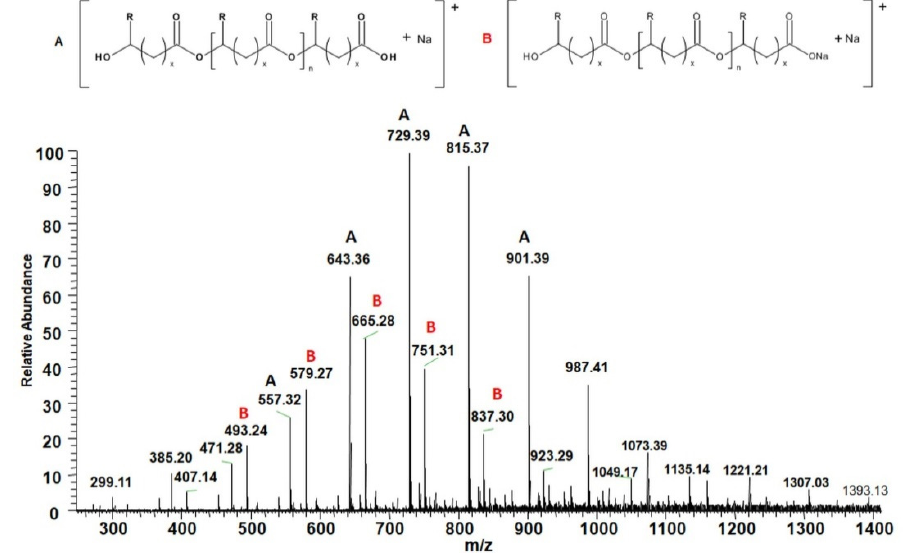
Figure 7. ESI–MS spectra (in positive ion mode) of oligo(3HB- co -4HB) / 30WF after 70 days of degradation in water (for 3-HB units R = CH 3 and x = 1; for 4-HB units R = H and x = 2).